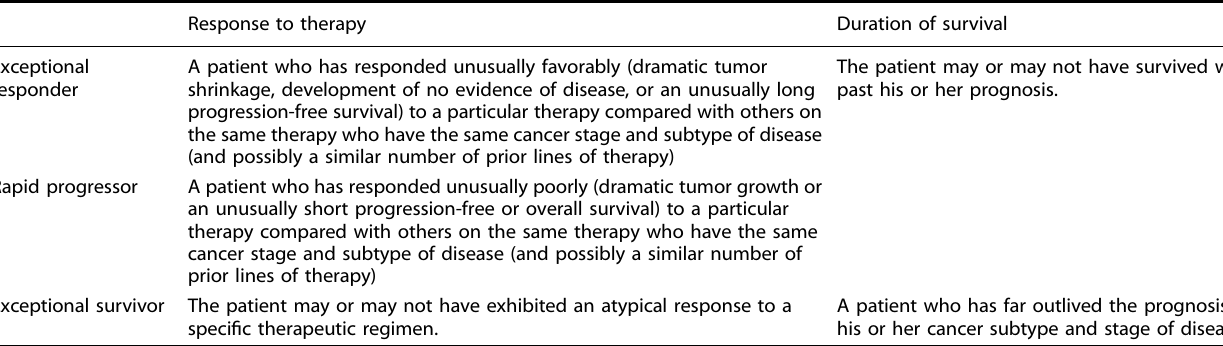
Table 2. Framework for three categories of atypical responders Response to therapy Duration of survival Exceptional